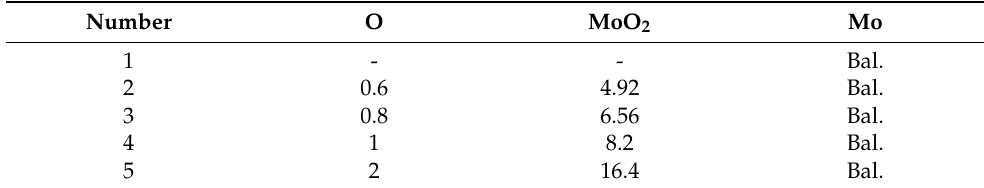
Figure 1. Morphology of ( a ) pure Mo, ( b ) MoO 2 powders, and ( c ) Mo and MoO 2 powders mixture. Table 1. Designed chemical composition of Mo in wt.%.